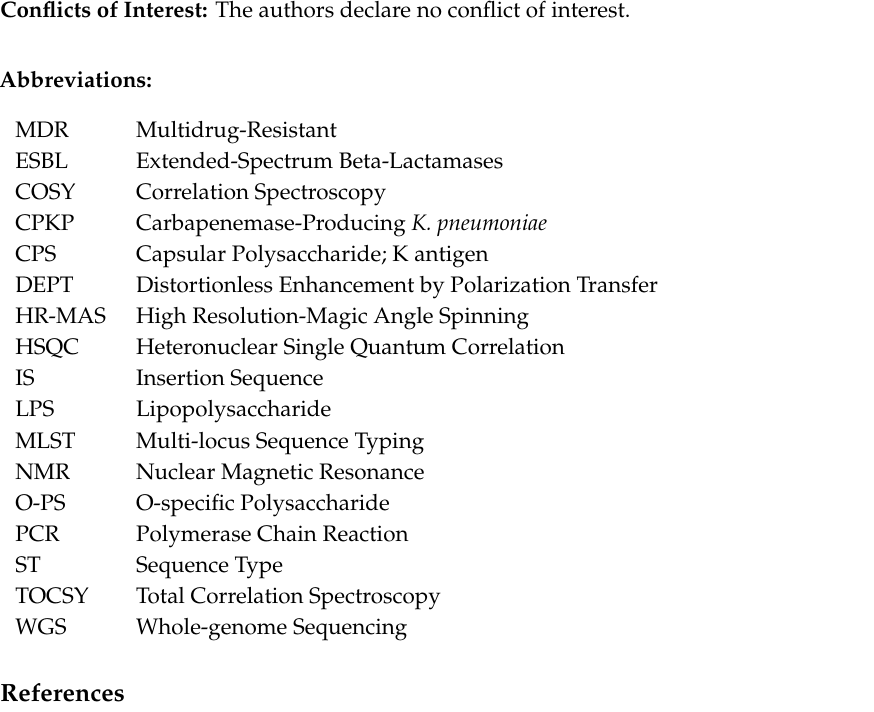
s1. Table S1: Kaptive Web analysis results for the 8130 assemblies of K. pneumoniae isolates. Isolates belonging to the O2v2 serotype are marked in green. Isolates belonging to the O1v2 serotype are marked in blue; Table S2: Kaptive analysis results extracted for the 55 K. pneumoniae O2 variant 2 genomes characterized by IS occurrence. Each color indicates closely related strains characterized by genetic similarity. Separately analyzed isolates are not colored; Table S3: Kaptive analysis results extracted for the 5 K. pneumoniae O1 variant 2 genomes characterized by IS occurrence. Isolates belonging to the same strain are marked in